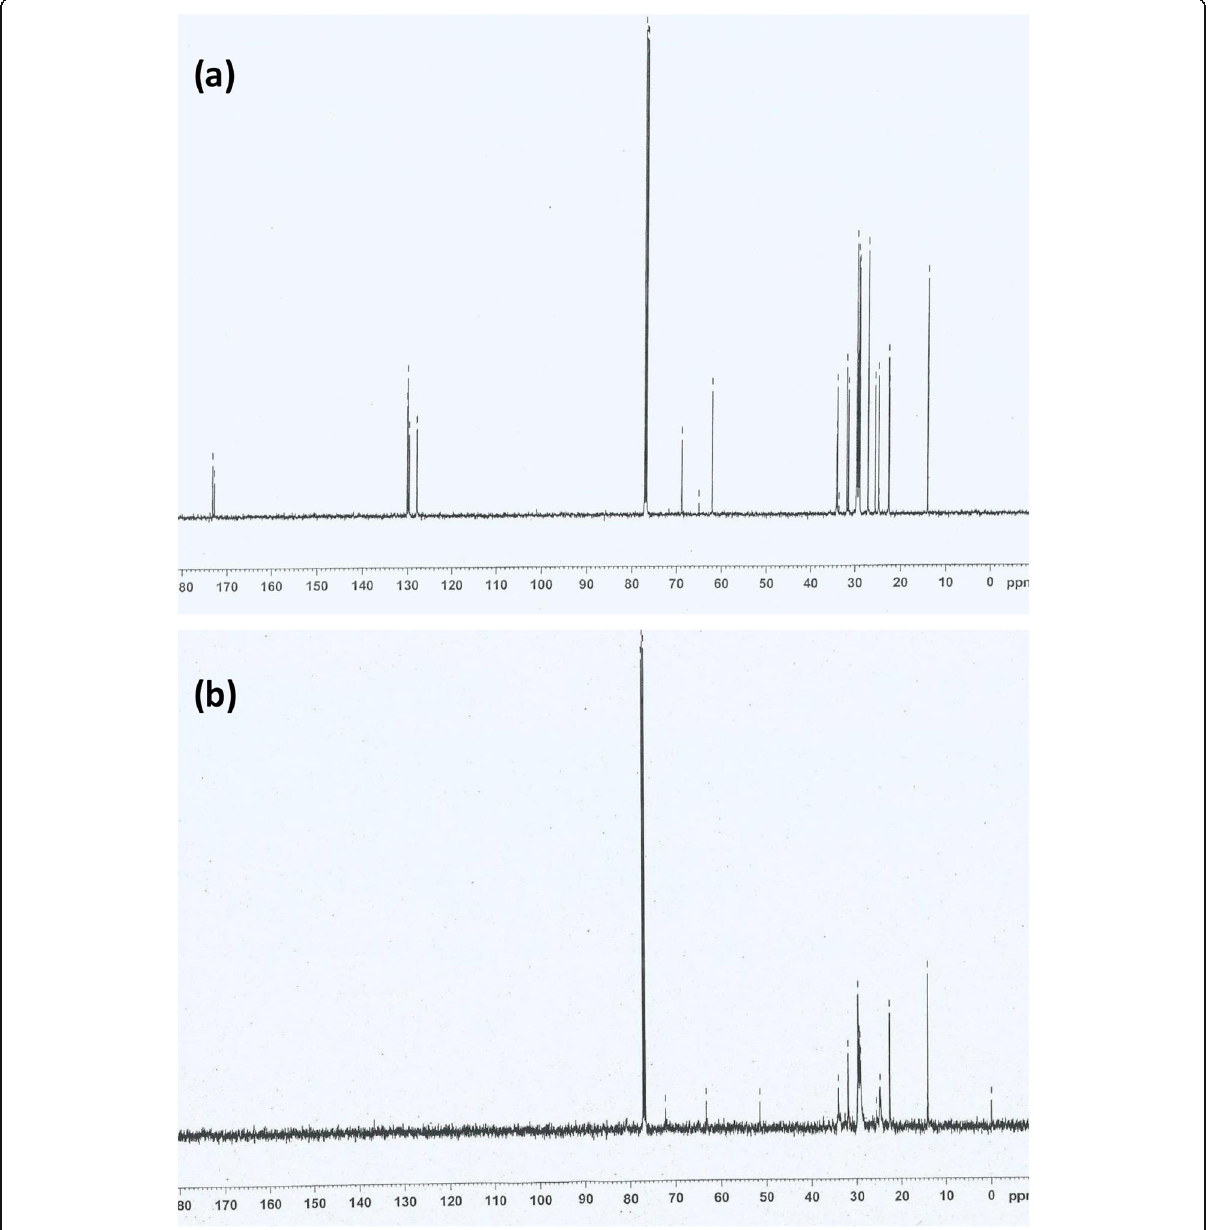
Fig. 4 13 C NMR spectra of a unsulfonated S. indicum oil b sulfonated S. indicum